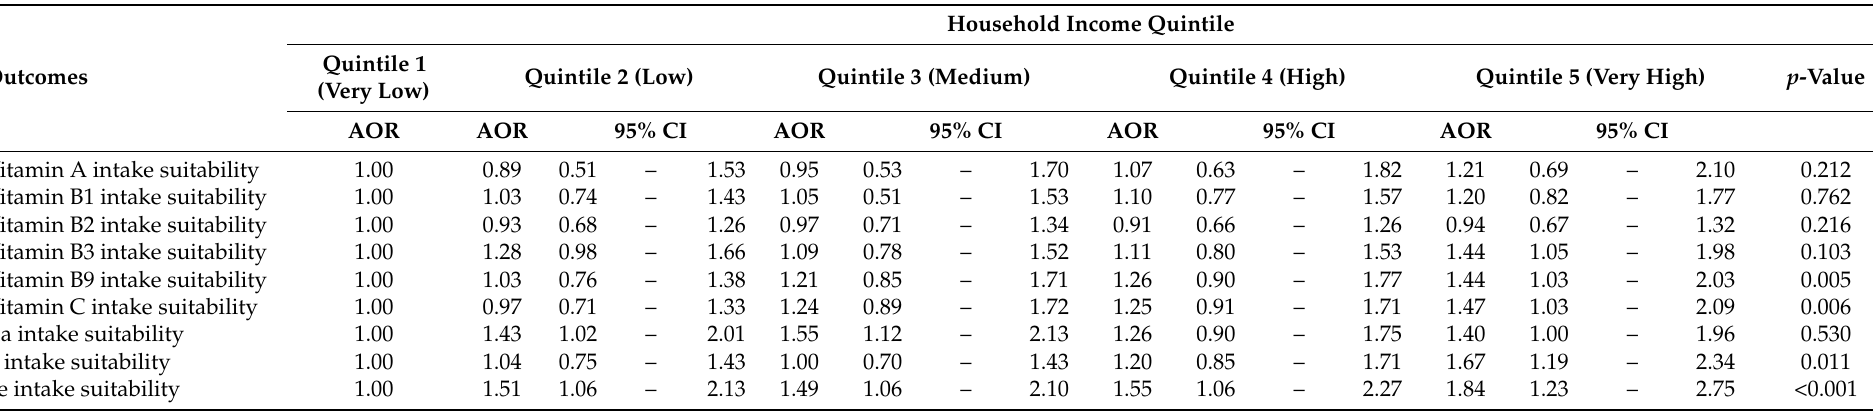
Table 3. Logistic regression analysis results of factors related to individual vitamin or mineral intake. Only the results according to household income quintile are shown. Adjusted odds ratio (AOR)s, 95% confidence intervals (CI), and trend p -values are shown.